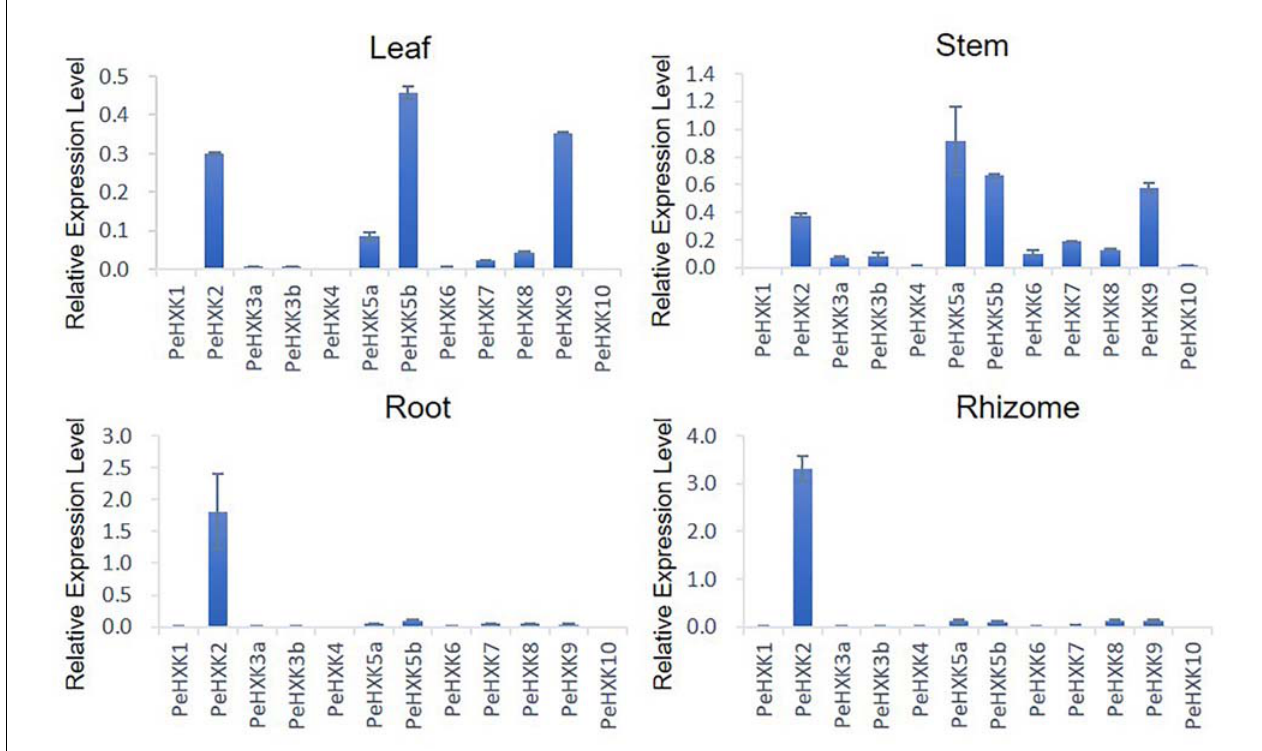
FIGURE 5 | Expression patterns of 12 PeHXK genes in four different tissues. Samples were collected from the leaf, stem, root, and rhizome. The Y-axis indicates relative expression levels of PeHXK genes to that of TIP41 , which is used as an inner control (Fan et al.,